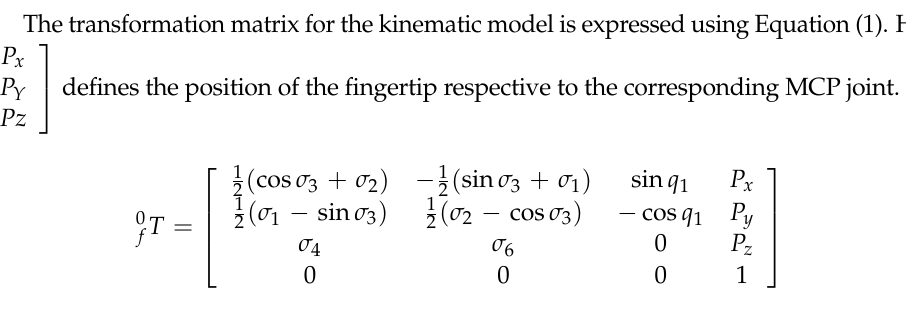
and the flexor motor’s angular rotation, θ (right). The left figure corresponds to the DIP joint’s extended position (see Figure 11(i)), where the angle between DPS and PPS, δ =